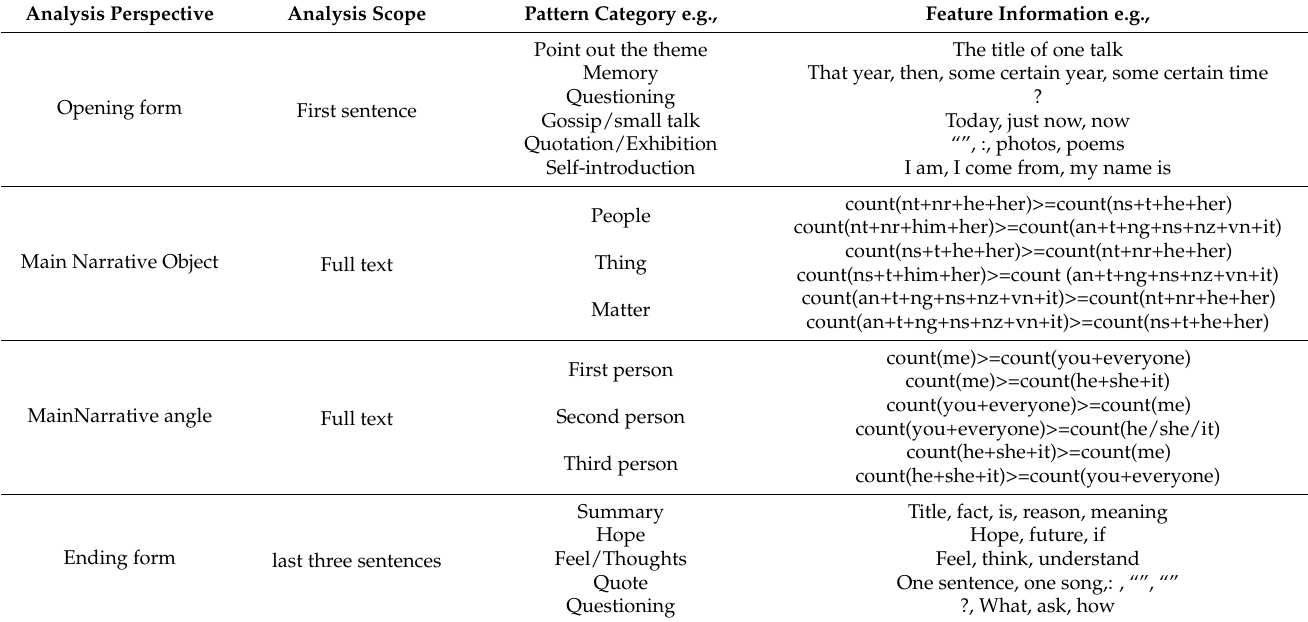
Table 4. Characteristic rules of YiXi talk pattern.